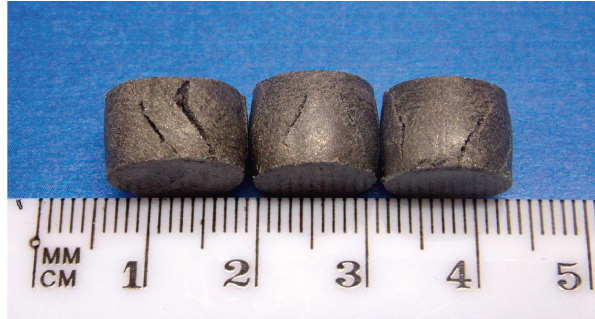
Figure 5: Green samples with 17, 0, and 35 vol.% space holder (from left to right) after compression testing at a strain rate of 0.001 s − 1